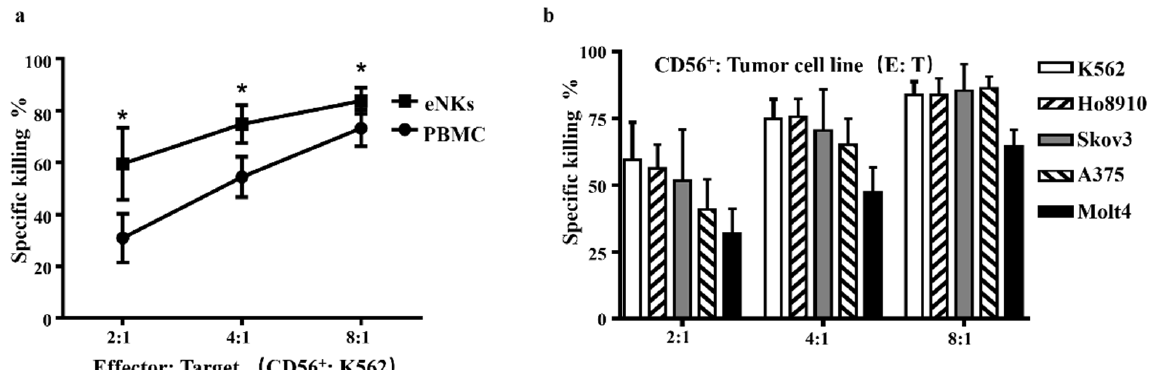
Figure 2. eNK enhanced cytotoxicity against multiple cancer cell lines ex vivo. ( a ) Comparison of the K562 cell killing activity by equal CD56 + cells numbers of non-selected PBMC CD56 + cells (determined by flow cytometry) before and after expansion. ( b ) eNK killing activity against different cancer cell lines. Results are representative of at least five independent experiments. Data were analyzed by two-tailed paired Student t -test. Data are represented as means ± SD. * p < 0.05.